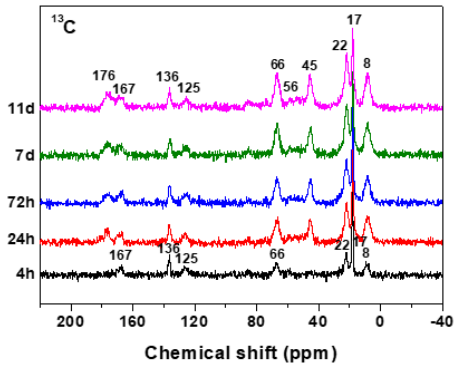
Figure 3. 13 C CP-MAS NMR spectra for the polysiloxane hybrids synthesized from [TMOS]/[MPTS] mixture at 65 °C for different times.